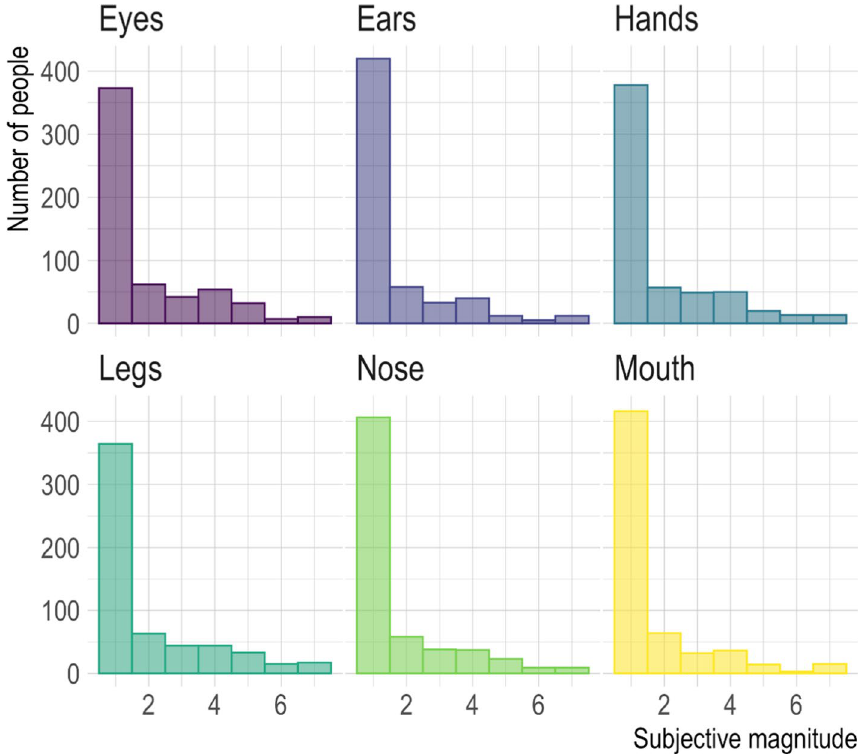
Foundation for Statistical Computing, Vienna, Austria. http:// www.R- proje ct.